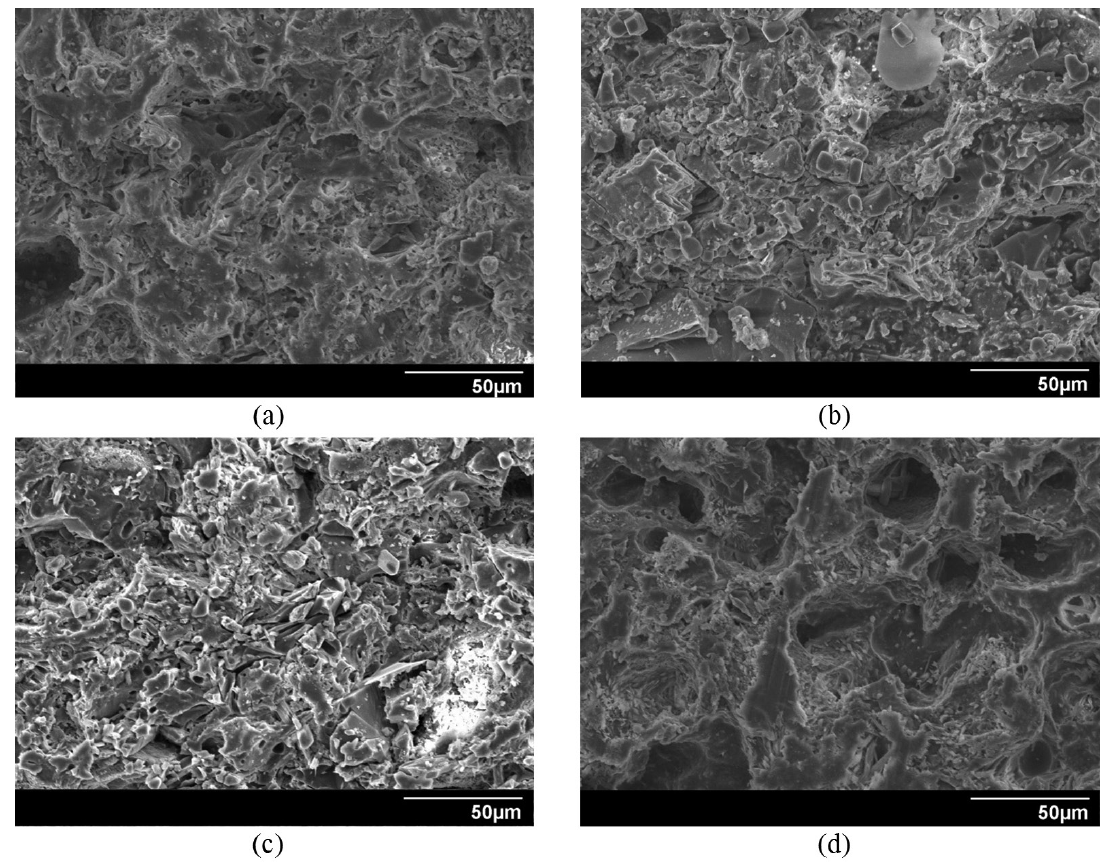
Figure 3. Micrographs (SEM) of compositions sintered at 1050 °C: (a) C-1, (b) C-2, (c) C-3, and (d) C-4.